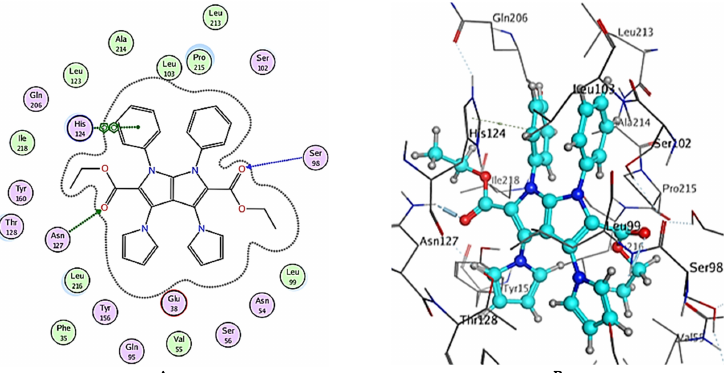
Figure 9. ( A ) Two-dimensional interactions and ( B ) three-dimensional interactions of compound 6 fitted into the binding site of NPC1L1 (pdb code: 3QNT) illustrating interactions with amino acid residues in the binding site. Table 4. Interaction types and binding scores for the formed complexes of Ezetimibe or compounds 1 – 7 with the active sites of NPC1L1 (pdb: 3QNT) performed using MOE 2019.01. Compound No.